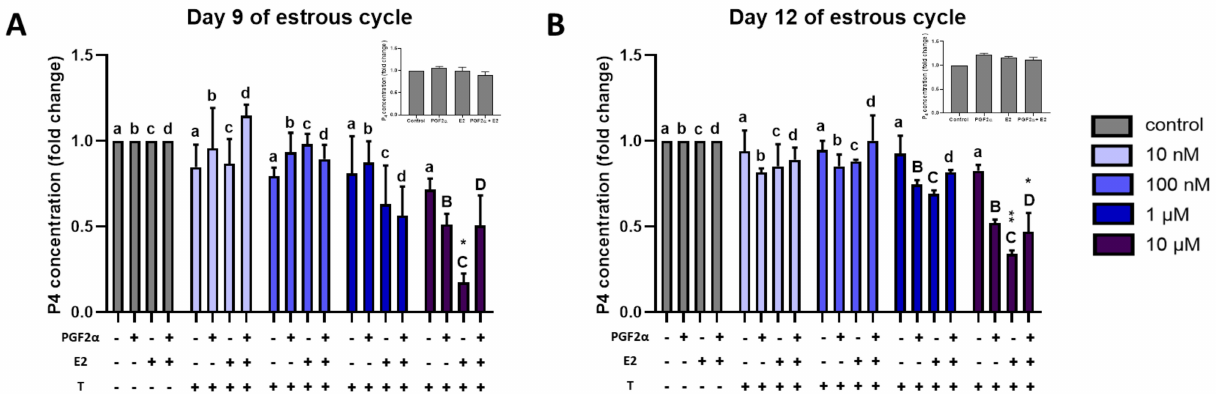
Figure 8. Progesterone concentrations in the corpus luteum explant-conditioned medium. The effect of triclosan (10 nM, 100 nM, 1 µ M, and 10 µ M) in combination with PGF2 α (1 µ M), E2 (10 nM), and PGF2 α + E2 on progesterone secretion in the culture medium by a luteal explant collected on ( A ) Day 9 of the estrous cycle and ( B ) Day 12 of the estrous cycle. Insets in the Figure show no significant effect of PGF2 α , E2, and PGF2 α + E2 on progesterone secretion by luteal explant collected on Days 9 and 12 of the estrous cycle. Data are presented as mean ± SEM and were analyzed by one-way ANOVA with Sidak’s multiple comparison test. Small and capital letters denote a statistically significant difference between the comparison. Asterisks denote significant differences between T-only-treated explants and T in combination with E2 or PGF2 α + E2 (* p < 0.05 and ** p <